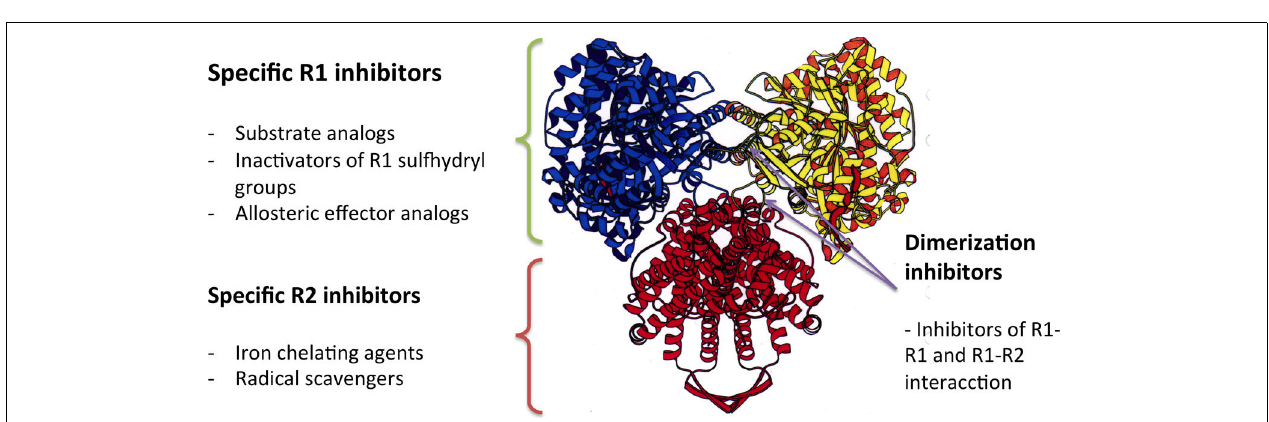
of the nrd gene through NrdR. Depending on which nucleotide is bound and the oligomerization state of the NrdR, this transcription factor can modulate the expression of the nrd genes through binding to the specific NrdR-box.